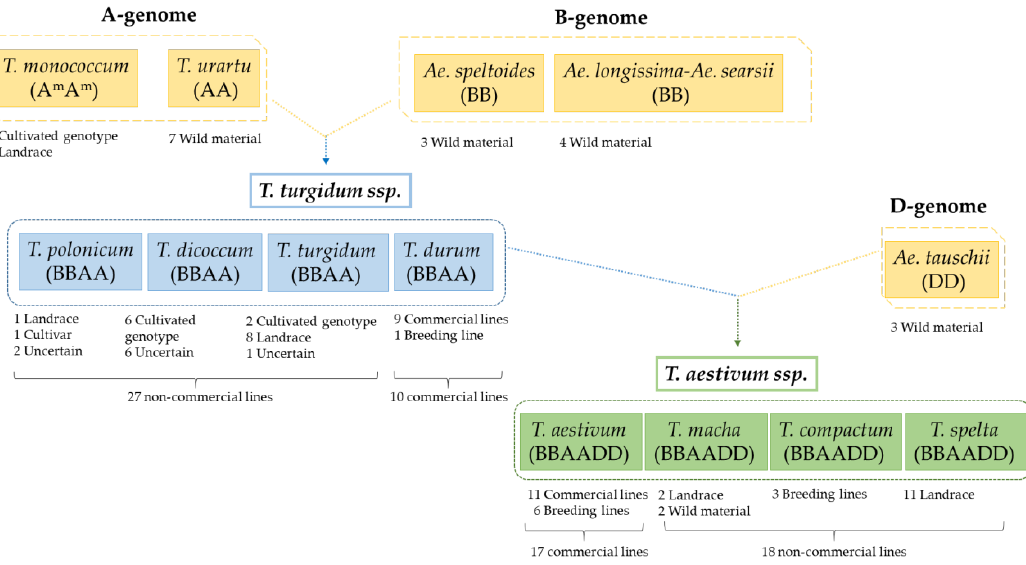
Figure 1. Schematic representation of 96 accessions from Triticum and Aegilops sp. showing their origin and breeding status. In total, there are thirty-five accessions of hexaploid wheats, thirty-seven accessions of tetraploid wheats, and twenty-four accessions of diploid wheats. AA, BB, and DD: diploids; BBAA: tetraploids; BBAADD: hexaploids (partially adapted from Ozuna and Barro) [3].